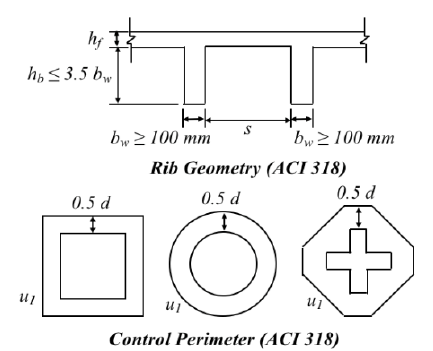
Figure 1. Rib geometry and control perimeter according to ACI 318